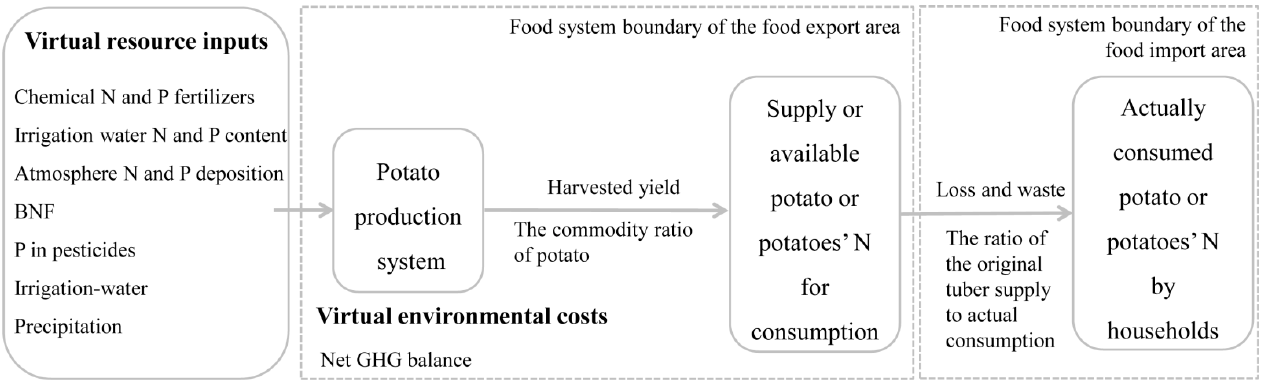
Figure 1. The calculation boundary of this study.